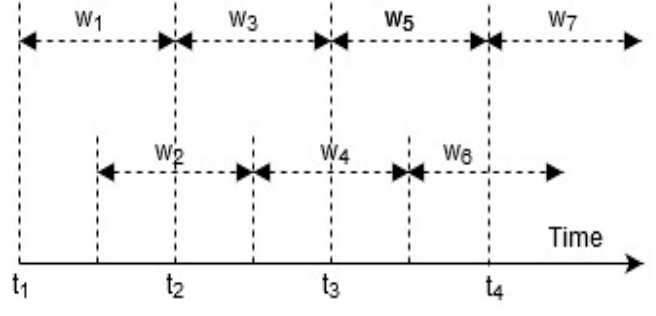
Figure 10. Sliding window with 50% overlaps.